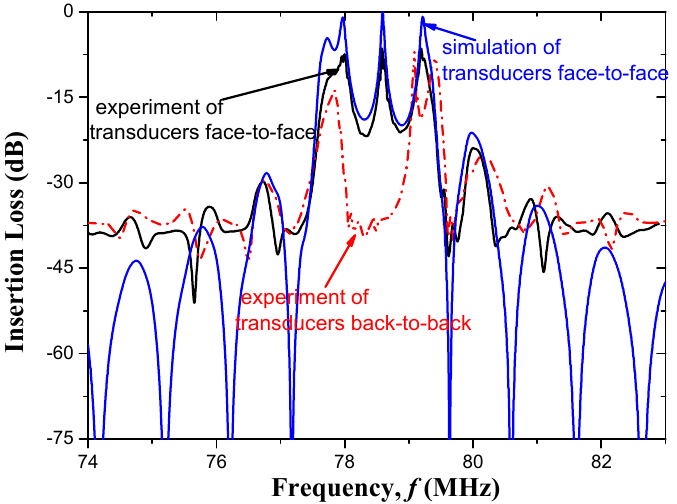
Figure 9. Frequency responses of the test devices with optimized EWC-SPUDT cells. In addition, as a contrast, two SAW delay lines with traditional EWC-SPUDT cells were designed, fabricated, and measured. The insertion loss of the transducers face-to-face (cid:0) (cid:1) ( S ) ) and back-to-back ( IL = − 20 log S (cid:48) ( IL = − 20 log ) are shown in Figure 10. The 21 10 10 21 results show that the response near the center frequency with transducers face-to-face is better than with the transducers back-to-back, but the difference is not obvious.